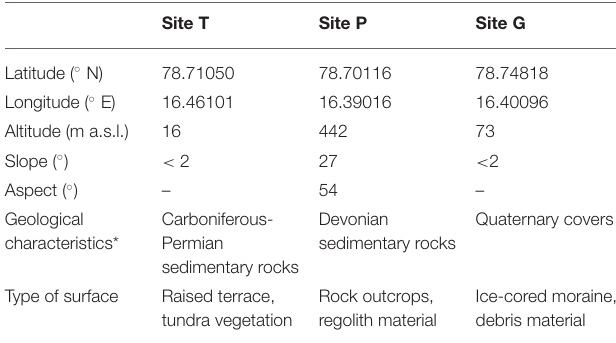
FIGURE 1 | Map of Petunia Bay and the sampling sites: T, P, and G. The modified map of Petunia Bay is based on the Svalbardkartet data, Norwegian Polar Institute. TABLE 1 | The geographical and geological characteristics of the sampling sites in Petunia Bay, Central